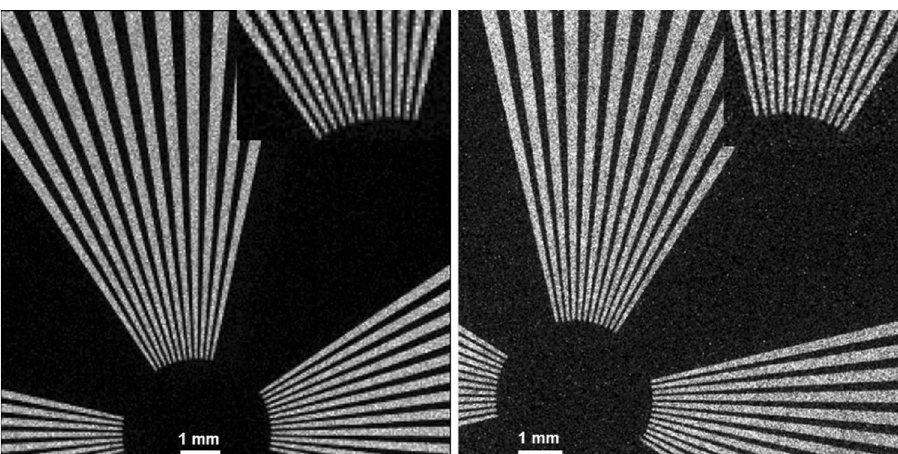
Figure 6. X-ray resolution target images using (left) Timepix camera with a Si sensor, and (right) PEALPB camera. The insets in the picture show the magnified area of the highest resolution end of the resolution target. The innermost lines have a Nyquist frequency of 10 l p/mm.